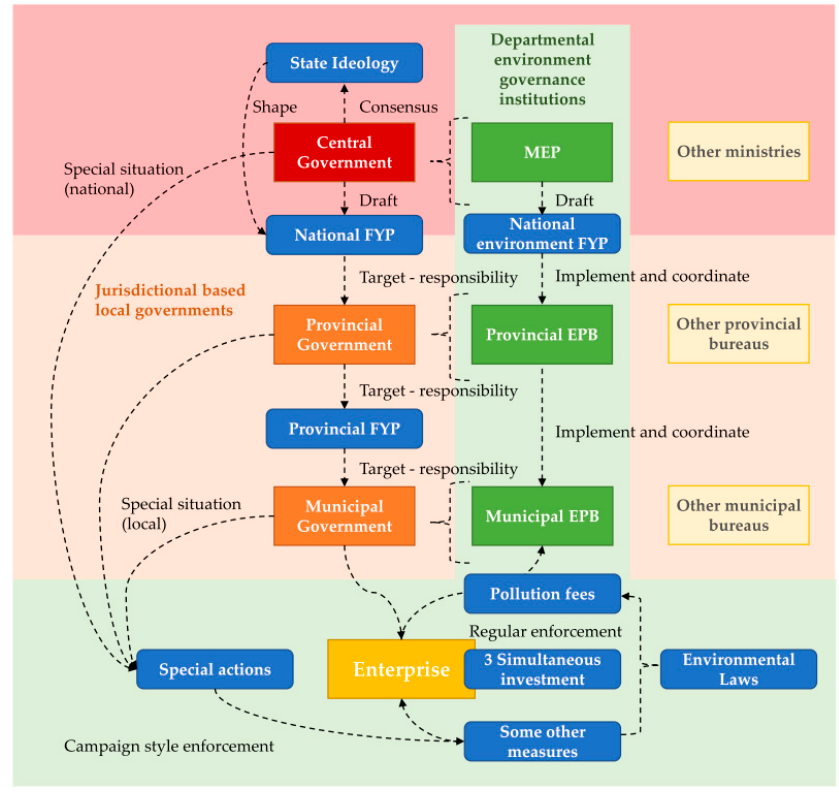
Figure 4. Environmental governance in China.